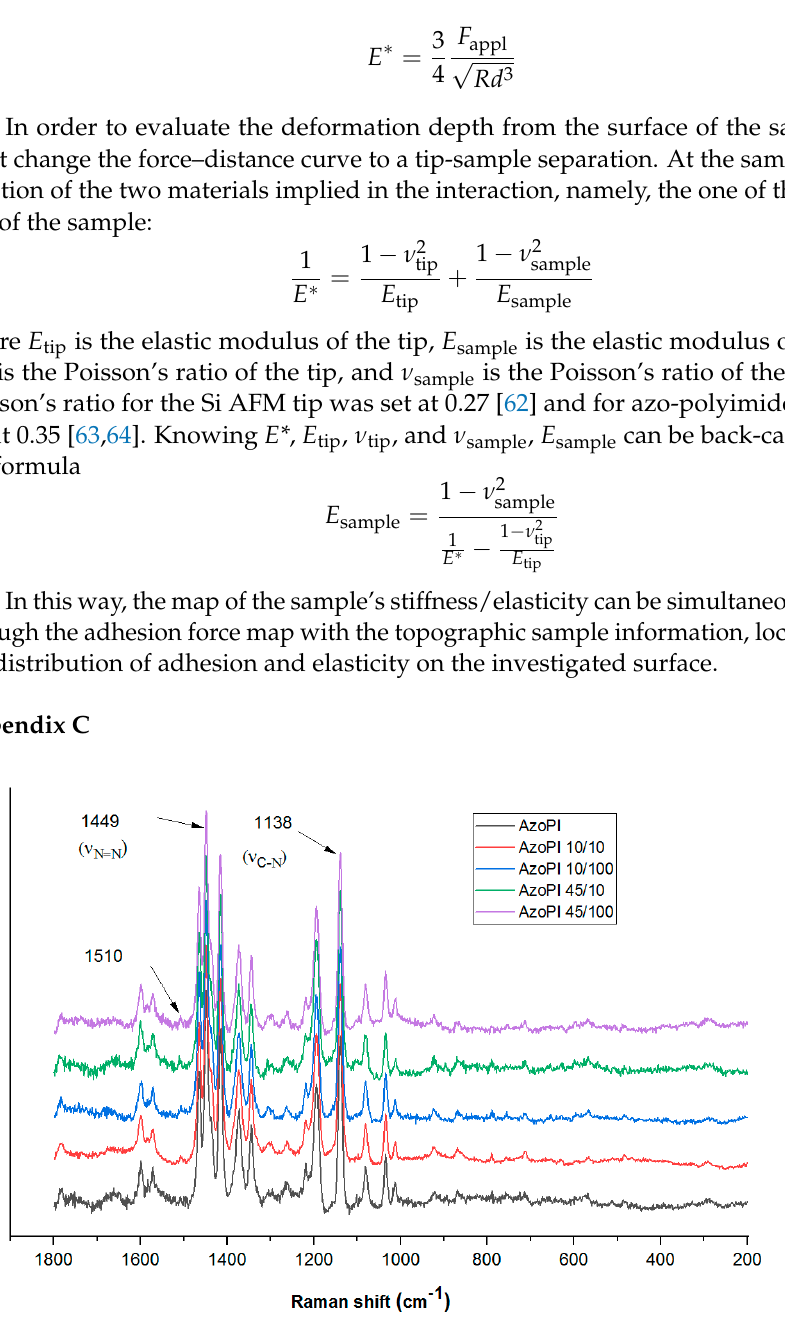
Figure A1. Raman spectra recorded on pristine and irradiated AzoPI film surfaces.